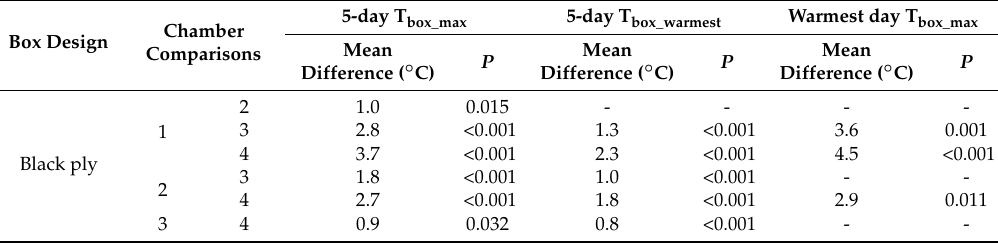
Table 3. Statistically significant ( P = <0.05) pairwise comparison between chamber temperatures within each box design for 5-day T box_max , 5-day T box_warmest and warmest day T box_max (n = 4 for each